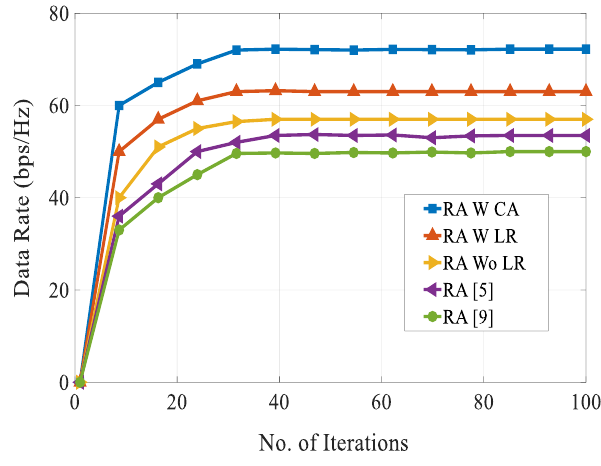
Figure 9. Data rate vs. no. of iterations.